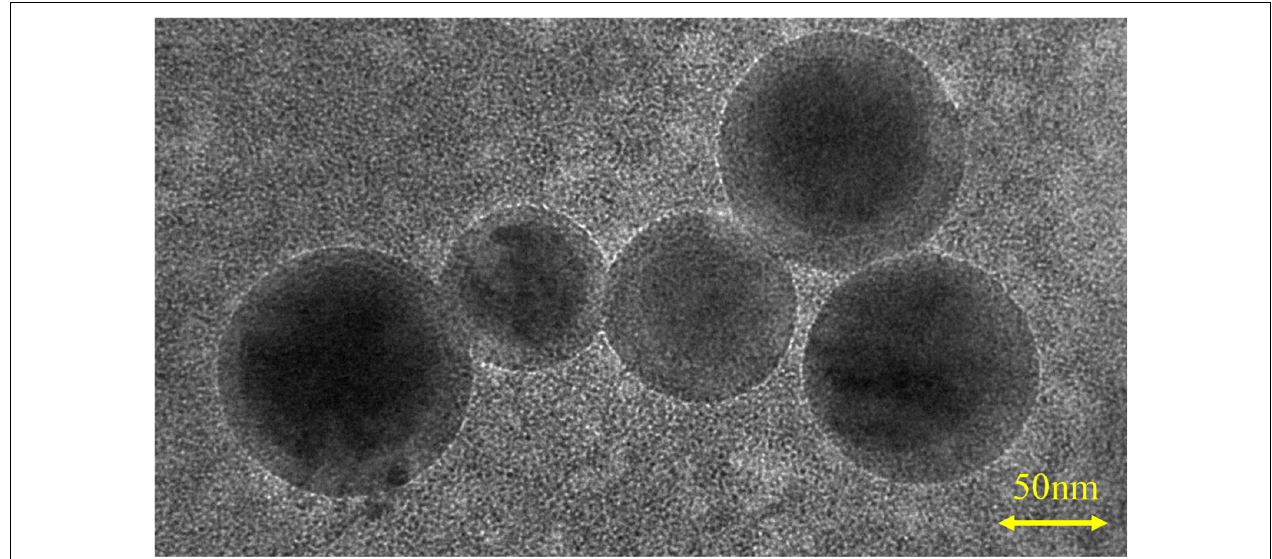
FIGURE 1 | Identification of neuron-derived exosomes. Image showing the double-layer membrane structure of exosomes, with a scale bar of 50 nm.